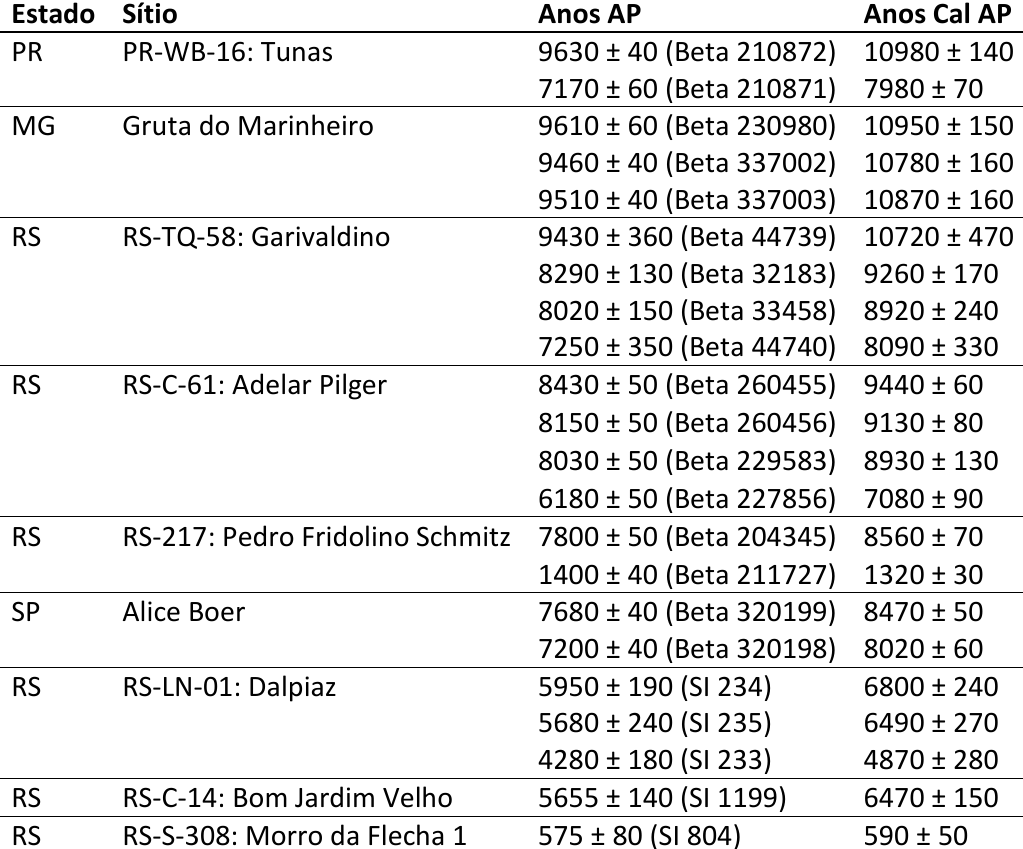
Tabela 2. Sítios arqueológicos e seus respectivos estados de origem, datações absolutas (Anos AP) com o código do laboratório e datações calibradas (Anos Cal AP). As datações podem ser encontradas em Brochado & Schmitz (1973); Miller (1974); Ribeiro et al. (1989); Ribeiro & Ribeiro (1999); Schmitz (2006); Koole (2007; 2014); Chmyz et al. (2008); Araujo (2012); Dias (2012); Okumura & Araujo (2014; 2015a). As datas foram Table 2. Archaeological sites and their respective states of origin in Brazil; absolute dates (years before present) with laboratory code; and calibrated dates (calibrated years before present). Dates can be found in Brochado